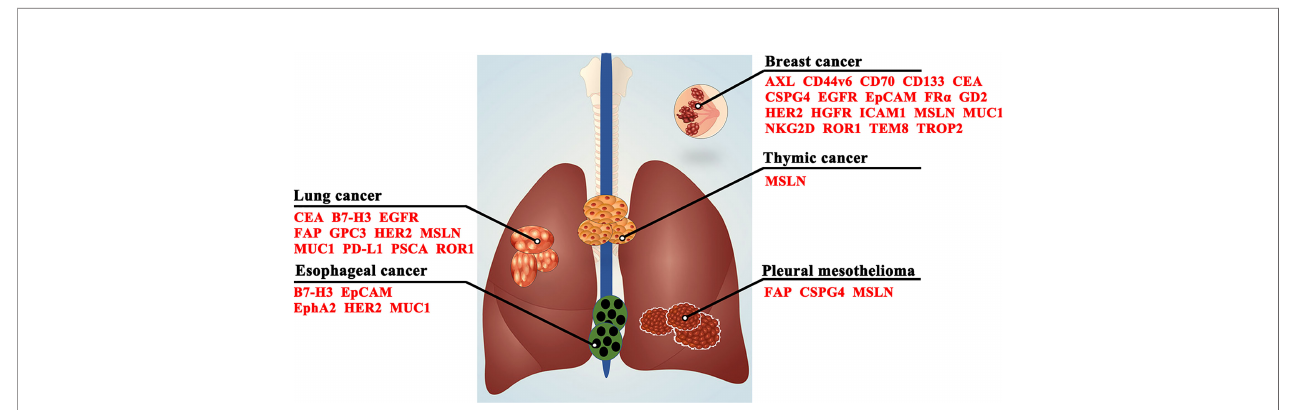
FIGURE 3 | Target antigens for CAR-T cell therapy in thoracic malignancies. CD44v6, CD44 containing variant exon v6; CEA, carcinoembryonic antigen; CSPG4, chondroitin sulfate proteoglycan 4; EGFR, epidermal growth factor receptor; EpCAM, epithelial cell adhesion molecule; EphA2, erythropoietin-producing hepatocellular carcinoma A2; FAP, fi broblast activating protein; FR a , folate receptor a ; GD2, glycolipid disialoganglioside; GPC3, glypican-3; HER2, human epidermal growth factor receptor 2; HGFR, hepatocyte growth factor receptor; ICAM1, intercellular adhesion molecule-1; MSLN, mesothelin; MUC1, mucin 1; NKG2D, natural killer group 2, member D; PD-L1, programmed death-ligand 1; PSCA, prostate stem cell antigen; ROR1, receptor tyrosine kinase-like orphan receptor 1; TEM8, tumor endothelial marker 8; TROP2, trophoblast cell surface protein